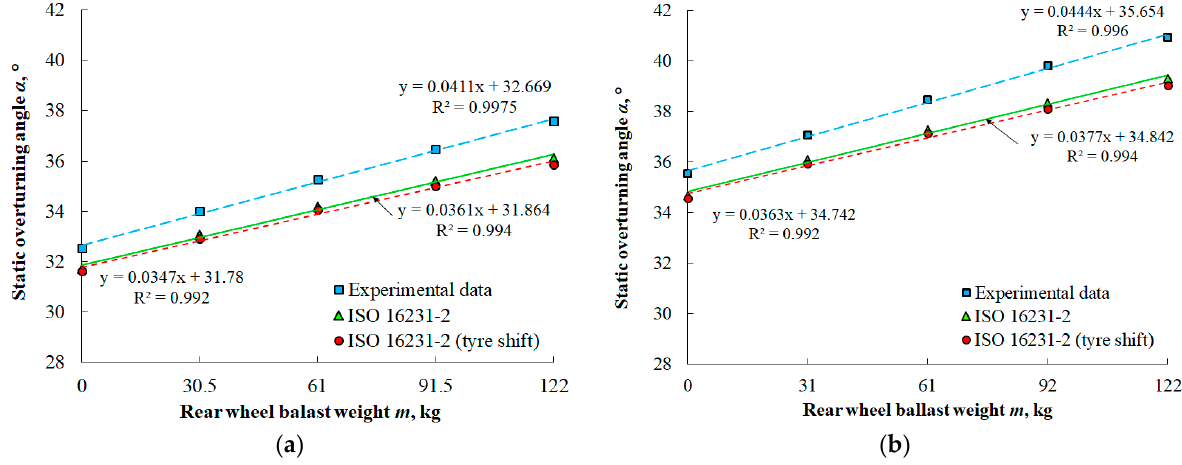
Figure 10. Influence of the tyre shift (lateral tyre deformation) on the static overturning angle calculated according to standard [12]: ( a ) standard overall width on tyres ( o = 0.795 m), ( b ) extended overall width on tyres ( o = 0.885 m).